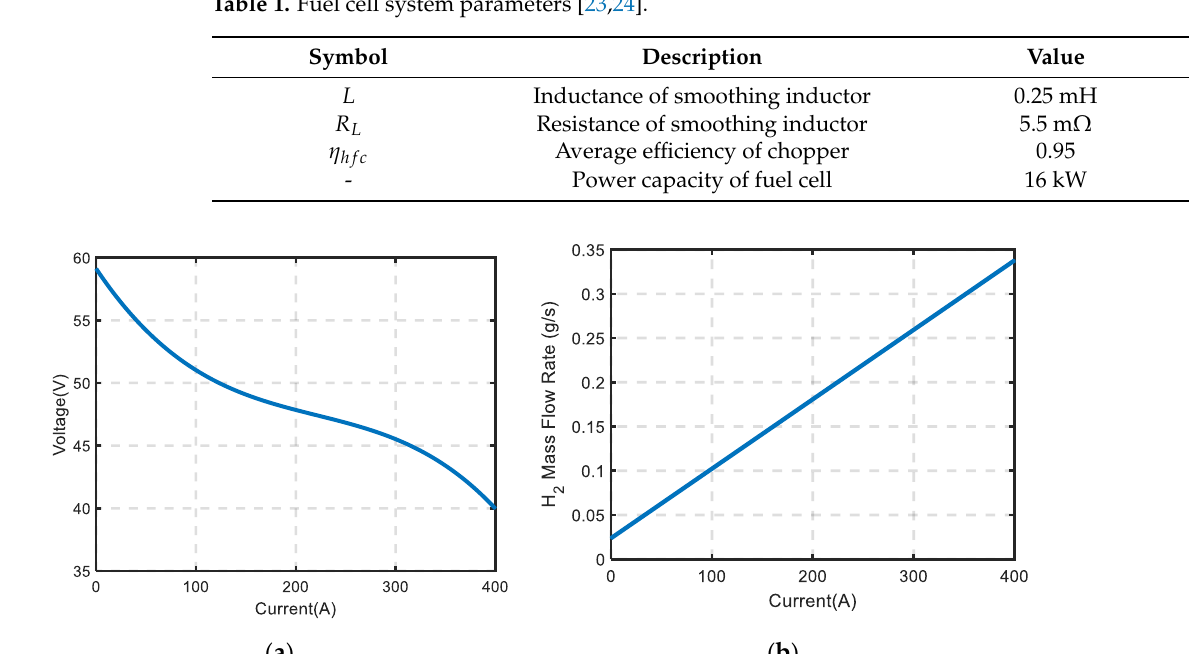
Table 1. Fuel cell system parameters [23,24].